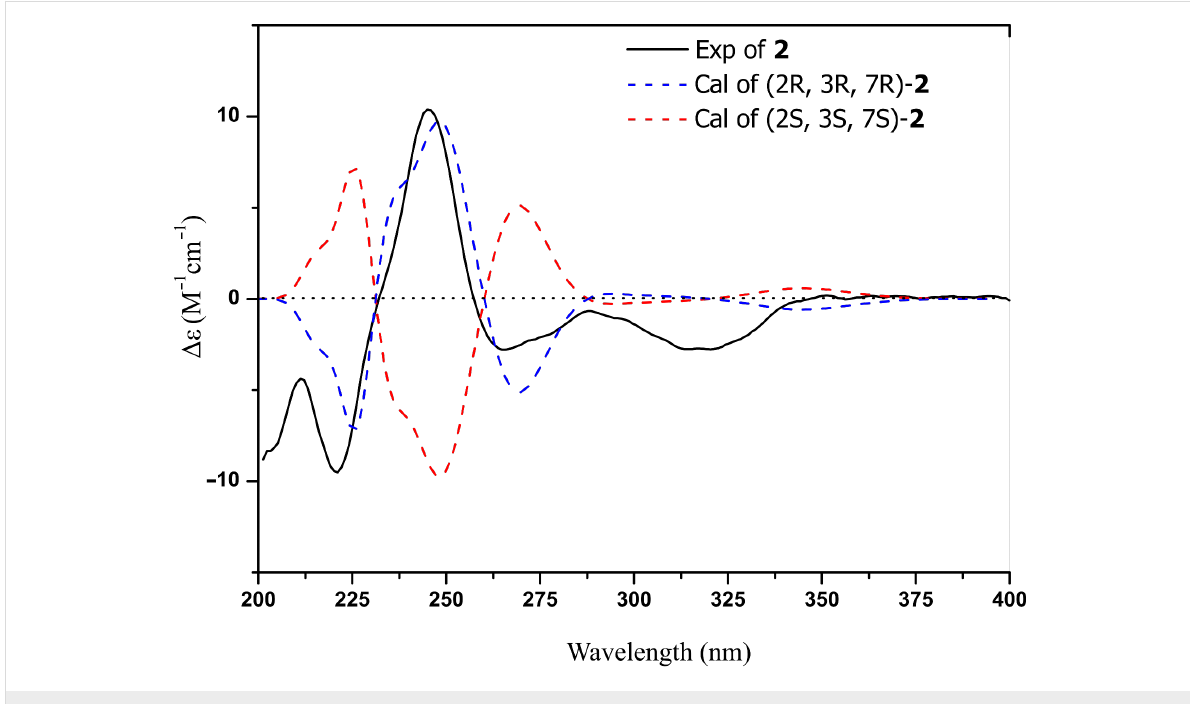
Figure 4: Comparison of the experimental and calculated ECD spectra of 2 .